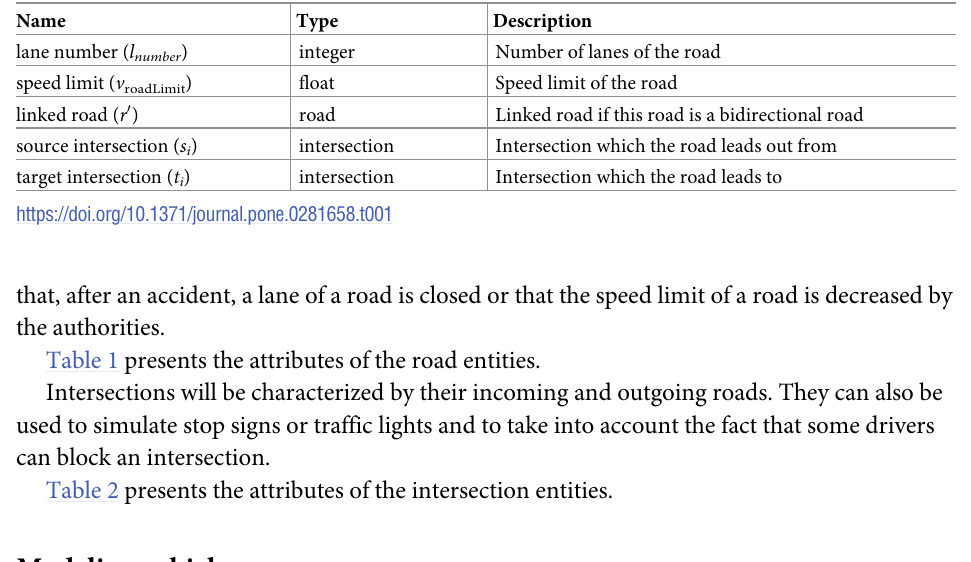
Table 1. Attributes of the road entities.